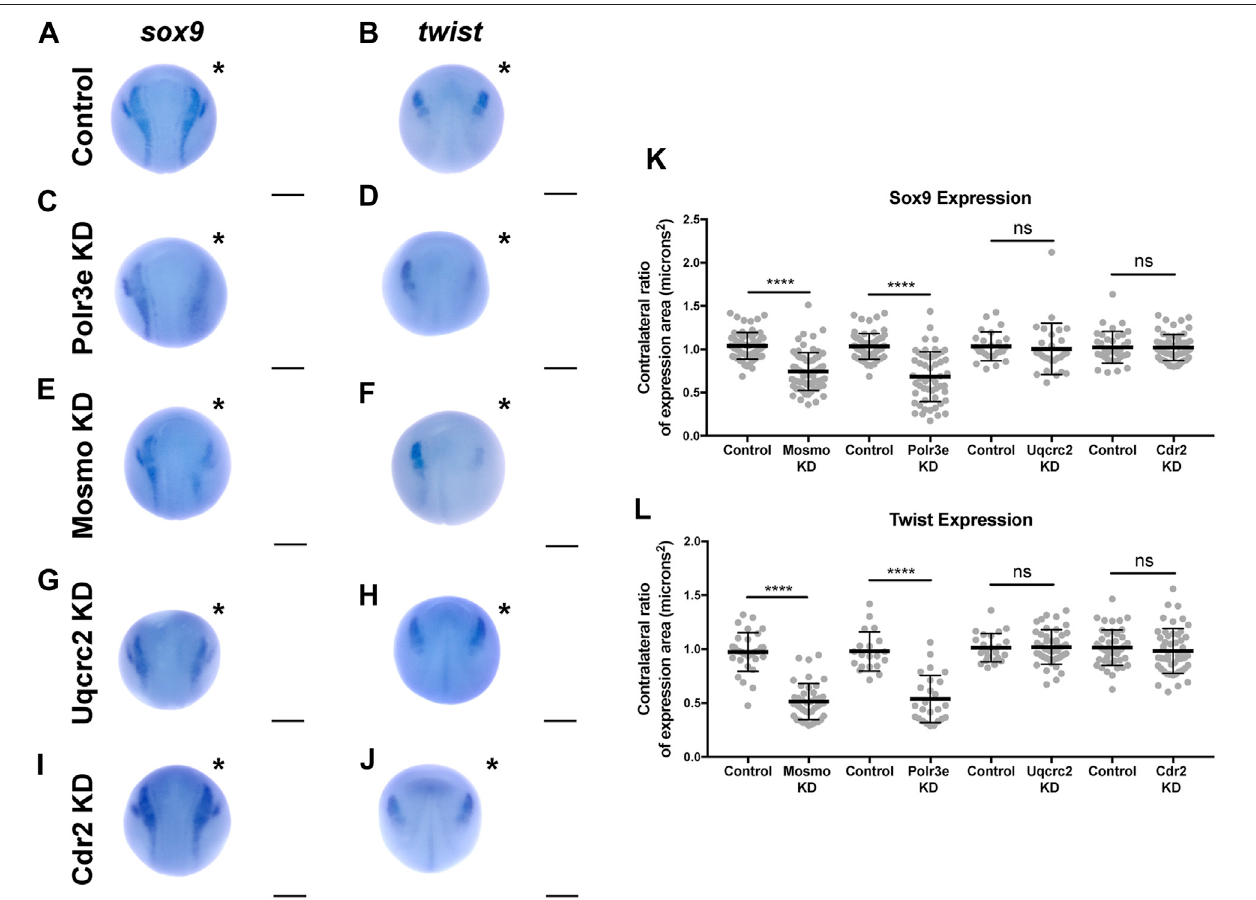
FIGURE 6 | Manipulation of Polr3e and Mosmo affects NCC speci fi cation In situ hybridization utilized (A,C,E,G,I) antisense mRNA probe against sox9 and (B,D,F,H,J) antisense mRNA probe against twist . Each column of panels are dorsal views of two sides of the same embryo. Embryos were unilaterally injected to KD eachindividual16p12.1-affectedgeneinhalfoftheembryoandtheotherhalfwasleftuninjected.Theleftsiderepresentstheuninjectedsideandtherightside,indicated with an asterisk (*), represents the injected side. Anterior of embryo is at the top. (K – L) Measurements were taken for the total area of the expression pattern for either sox9 (K) or twist (L) usingthepolygontoolinImageJbytakingratiosoftheinjectedsideversustheuninjectedside.Signi fi cancewasdeterminedusinganunpaired students t -test with these ratios. Partial depletion of either Mosmo or Polr3e signi fi cantly reduced the total area of expression for both sox9 and twist , while partial depletion of either Uqcrc2 or Cdr2 did not signi fi cantly affect the total area of expression for either NCC speci fi cation marker. (Embryos quanti fi ed with sox9 probe: Control for Polr3e = 60, Control for Mosmo = 66, Control for Uqcrc2 = 25, Control for Cdr2 = 36, Polr3e KD = 55, Mosmo KD = 69, Uqcrc2 KD = 27, Cdr2 KD = 59. Embryosquanti fi edwith twist probe: ControlforPolr3e=20,Controlfor Mosmo=33,Control forUqcrc2 =23,ControlforCdr2 =46,Polr3eKD=25,MosmoKD=41, Uqcrc2 KD = 44, Cdr2 KD = 50). **** p < 0.0001, *** p < 0.001, ** p < 0.01, * p < 0.05, n.s., not signi fi cant. Scalebar = 300 μ